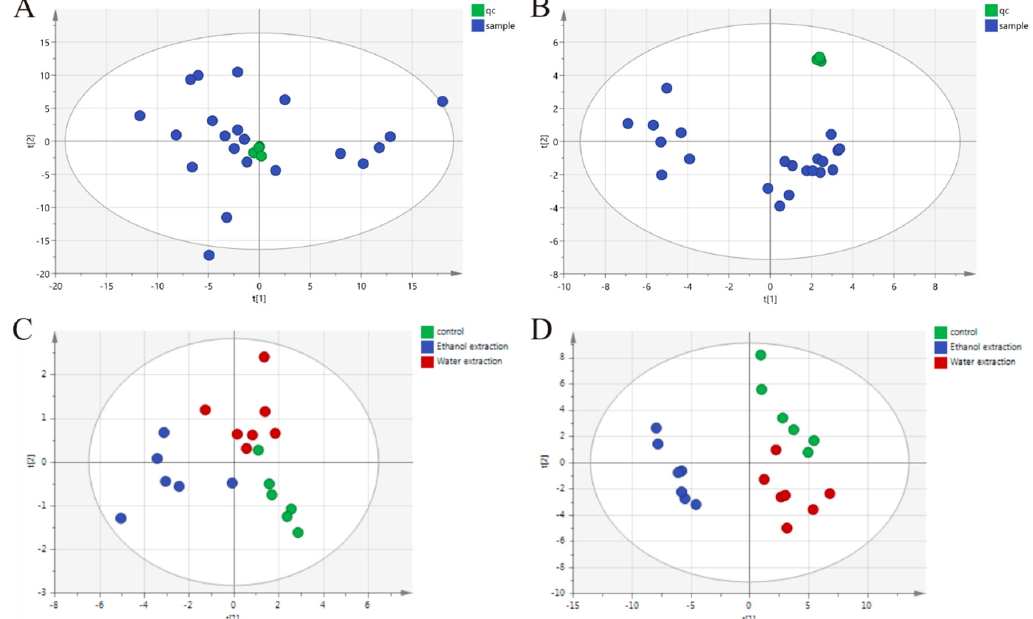
Figure 5. Multiple pattern recognition of the serum metabolites in the control, water extract, and ethanol extract groups on day 7. ( A ) QC of reversed phase C18 separation. ( B ) QC of hydrophilic chromatogram separation. ( C ) Representative figure of reverse phase C18 column detection chart. ( D ) Representative figure of hydrophilic chromatogram. Control group (green), ethanol extraction group (blue), water extraction group (red).